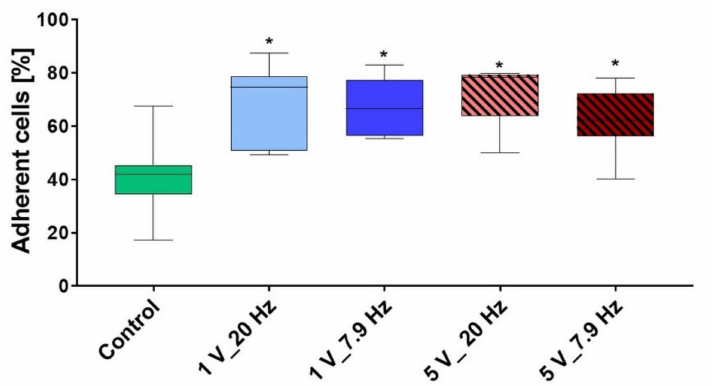
Figure 7. The adhesion of MG-63s after 10 min AC stimulation of the suspended cells. Note that after AC, the attachment of osteoblasts was significantly increased. (Cell count via FACSCalibur, median ± min/max, n = 7 independent experiments, one-way ANOVA posthoc Bonferroni, * p < 0.05 compared to Control).